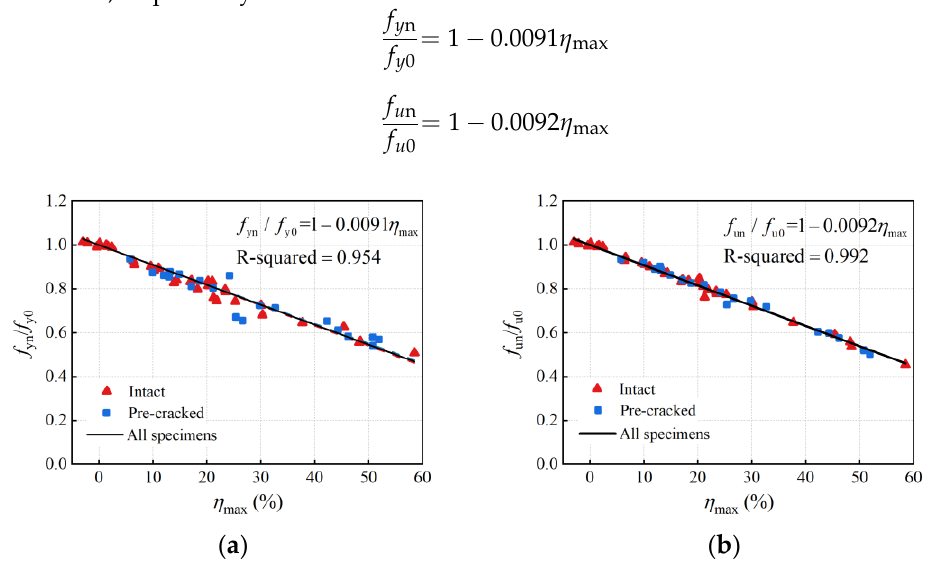
Figure 15. Relationships between nominal strength and maximum cross-section loss: ( a ) yield strength; ( b ) ultimate strength.